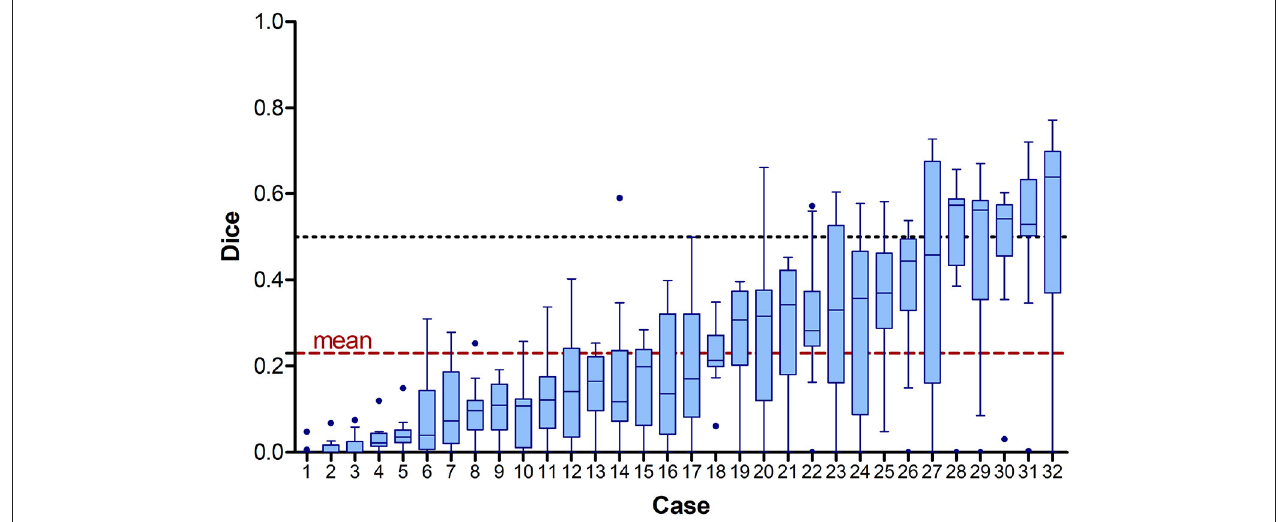
FIGURE 5 | Achieved Dice scores for each case across all 15 participating teams sorted by mean value. The dashed line shows the overall mean Dice score of 0.23 (red) and the 0.5 mark (black). Note that the case numbers were assigned according to ascending mean Dice score.